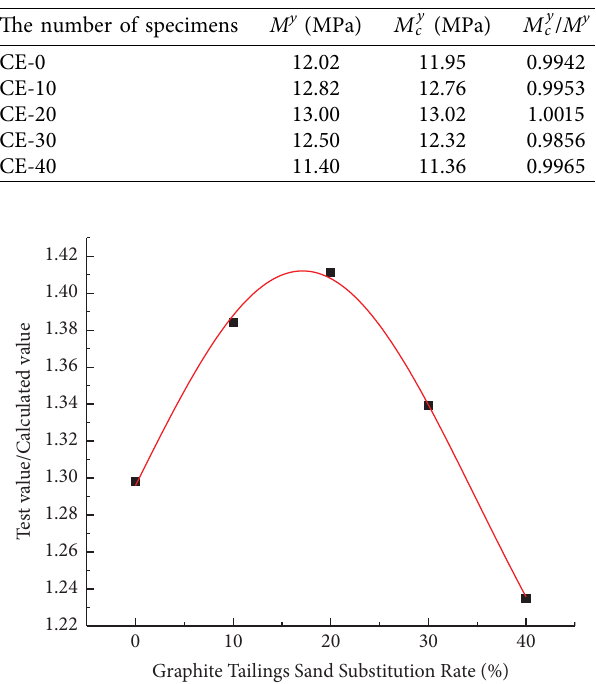
Figure 13: Gaussian function ftting curve of ultimate bearing capacity of concrete beams with diferent replacement rates of graphite tailings after chloride erosion.